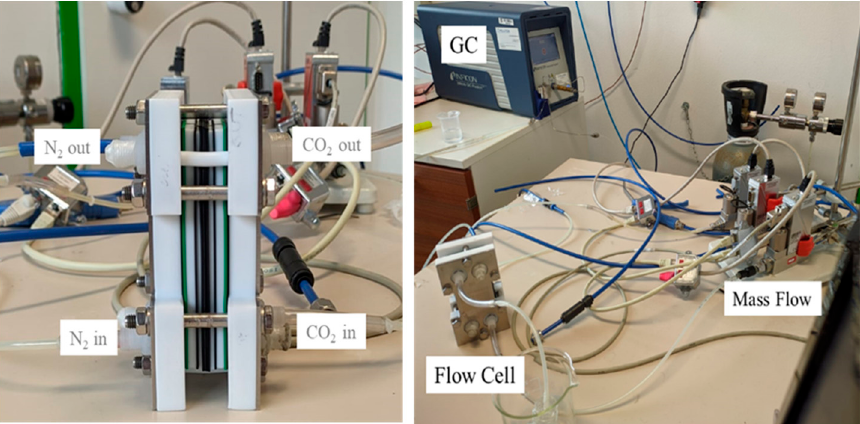
Figure 2. Experimental set up consisting of gas chromatograph, cell, and mass flow.